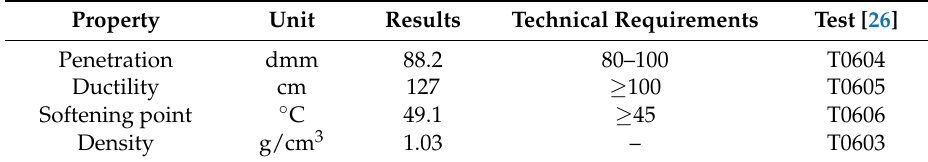
Table 1. Properties of